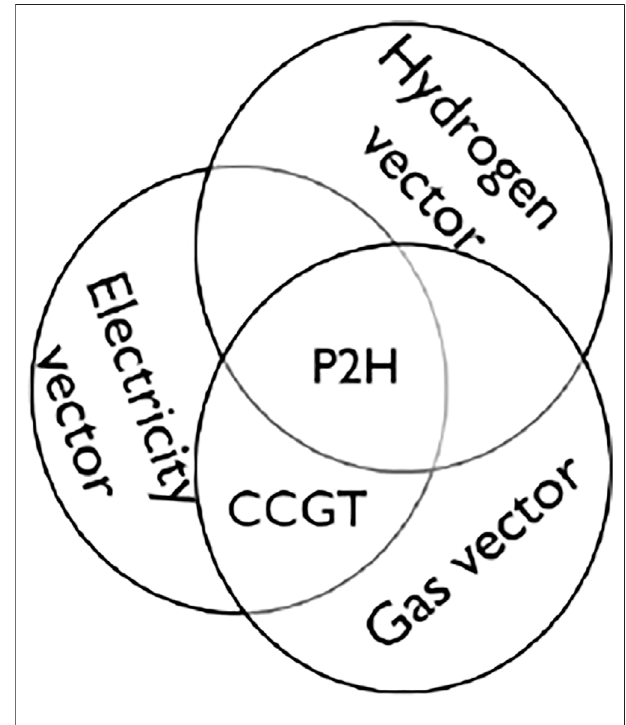
FIGURE 3 | Schematic of the coupling relation between electricity – gas – hydrogen energy